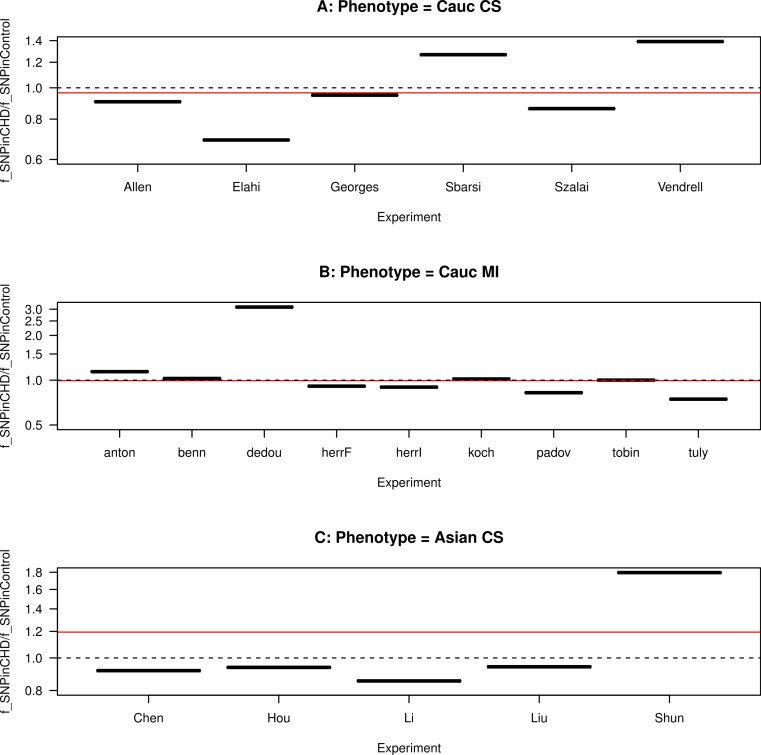
Funnel plot for the ratio of SNP fractions.The ratio of the fraction of SNP in the population of CHD patients to the fraction of SNP in the population of non-CHD patients, \documentclass[12pt]{minimal}
\usepackage{amsmath}
\usepackage{wasysym}
\usepackage{amsfonts}
\usepackage{amssymb}
\usepackage{amsbsy}
\usepackage{upgreek}
\usepackage{mathrsfs}
\setlength{\oddsidemargin}{-69pt}
\begin{document}
}{}${f}_{\text{SNPinCHD}}/{f}_{\text{SNPin}\overline{\text{CHD}}}$\end{document}fSNPinCHD/fSNPinCHD¯, for each study, grouped by ethnicity and CHD phenotype. (A) Caucasians with coronary stenosis; (B) Caucasians with myocardial infarction; (C) Asians with coronary stenosis. The solid horizontal line is the ratio of the combined data sets included in each panel. The dashed horizontal line marks the ratio equal to one.